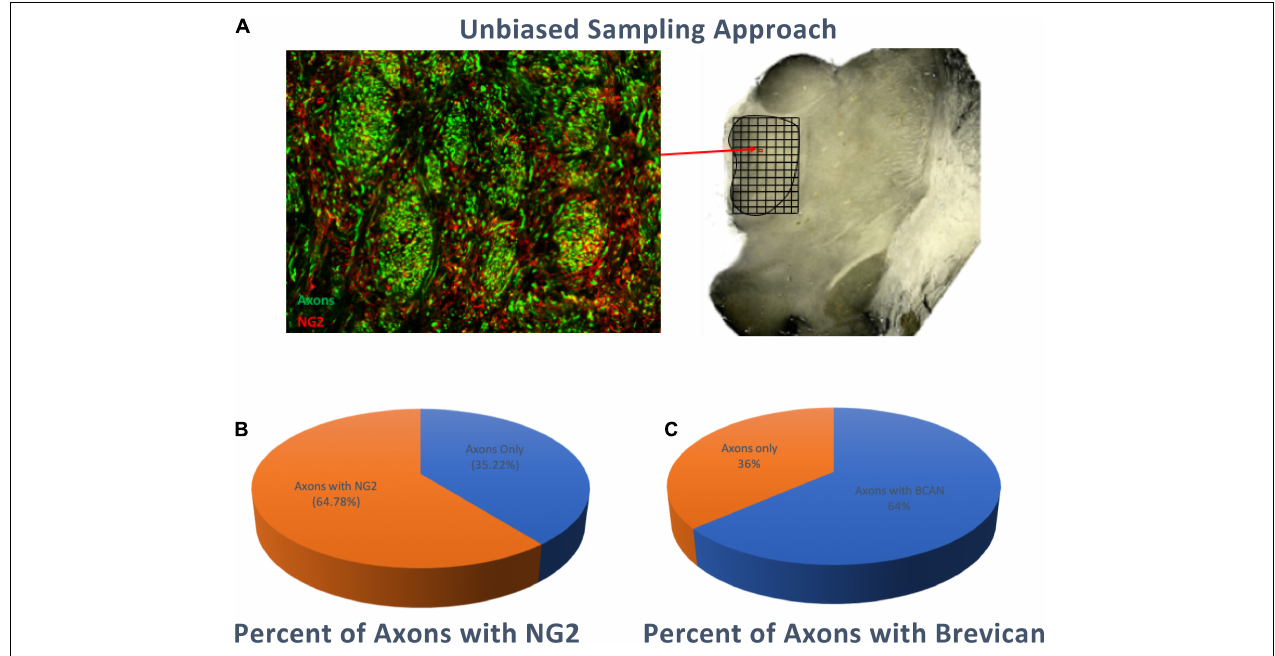
FIGURE 2 | Percentage of Axons surrounded by NG2 or BCAN Coats. Stereology-based sampling was used to quantify the number of SMI-312 immunoreactive axons and axonal coats within bundles of the MD (A) approximately 65% (standard deviation ± 3.3%) of axons were associated with NG2 immunoreactive coats (B) and 64% (standard deviation ± 2.7%) were associated with BCAN immunoreactive coats (C)